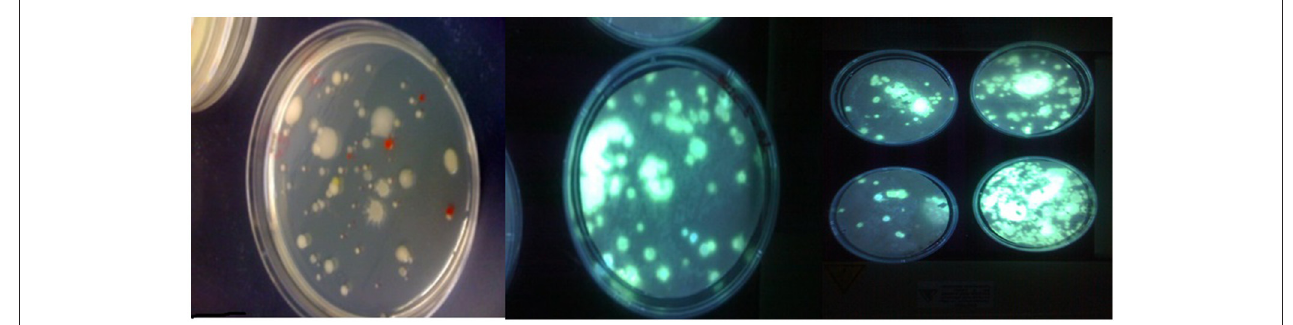
FIGURE 5 | Colony Overlay Procedure for Peptidases (COPP) Assay for Vibrionaceae identification (Hannum, 2007).